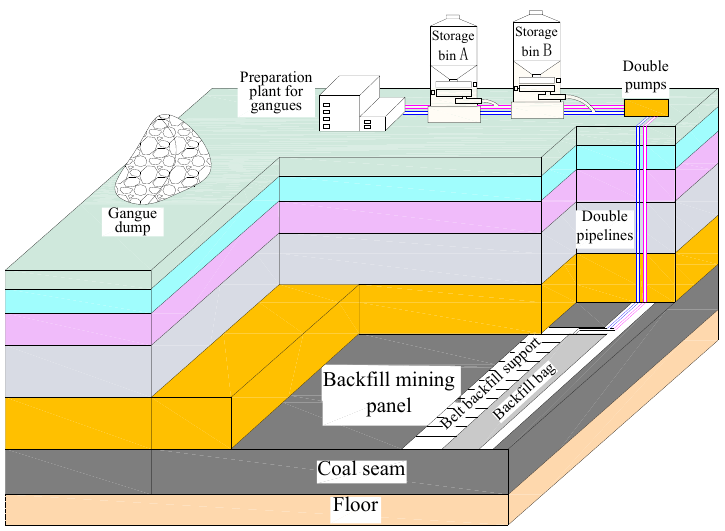
Figure 4. The principle of the backfill mining method with high-water-content material.